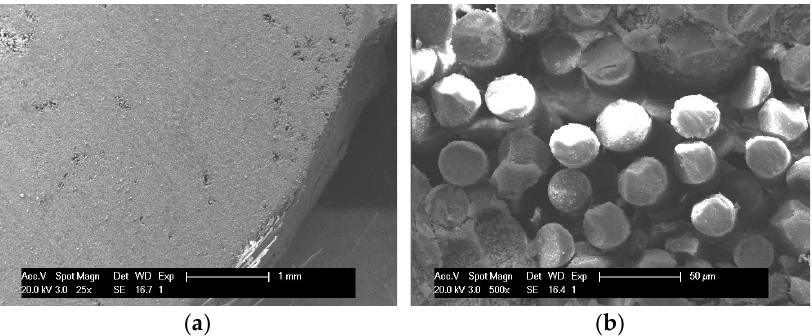
Figure 13. The microstructure of G2 after accelerated aging at 20 °C for 180 days: ( a ) 25 × G2; ( b ) 500 × G2.